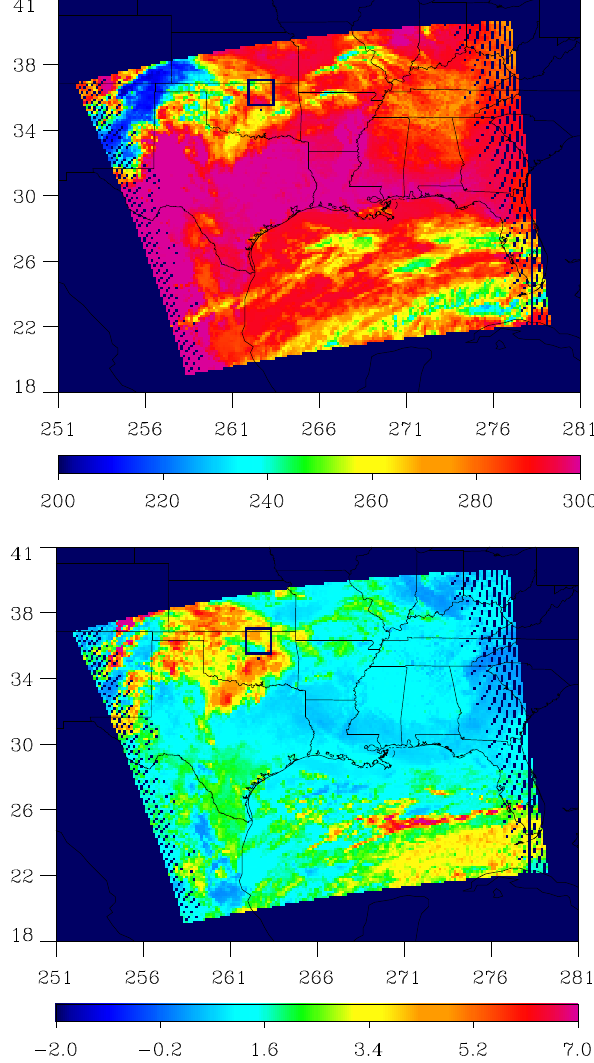
Fig. 2. Figure shows the MODIS 11.0 µm brightness temperature (top panel) and the 11.0µm minus 12.0µm BTD (bottom panel) for the 28 April 1925 GMT overpass. The SPEC 25 Learjet was located in thin cirrus in north central Oklahoma as shown by the high BTD areas within the black box in the bottom panel. High values of BTD for these cirrus indicate clouds dominated radiatively by small crystals. The low BTD areas in the lower-left portion of the black box and corresponding high 11.0µm brightness temperatures indicate regions of clear-sky or very thin cirrus